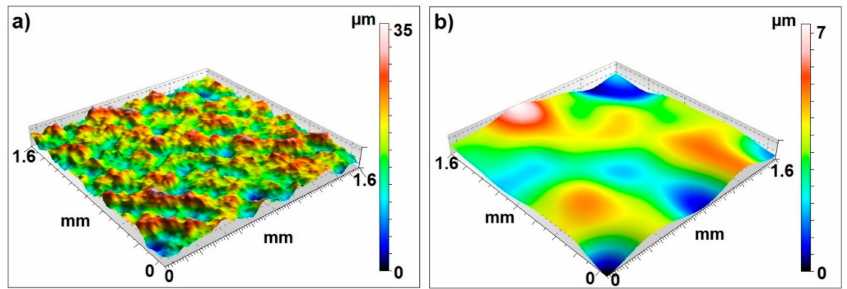
Figure 4. Frontal 3D surface topography: ( a ) surface before filtering, ( b ) surface waviness.